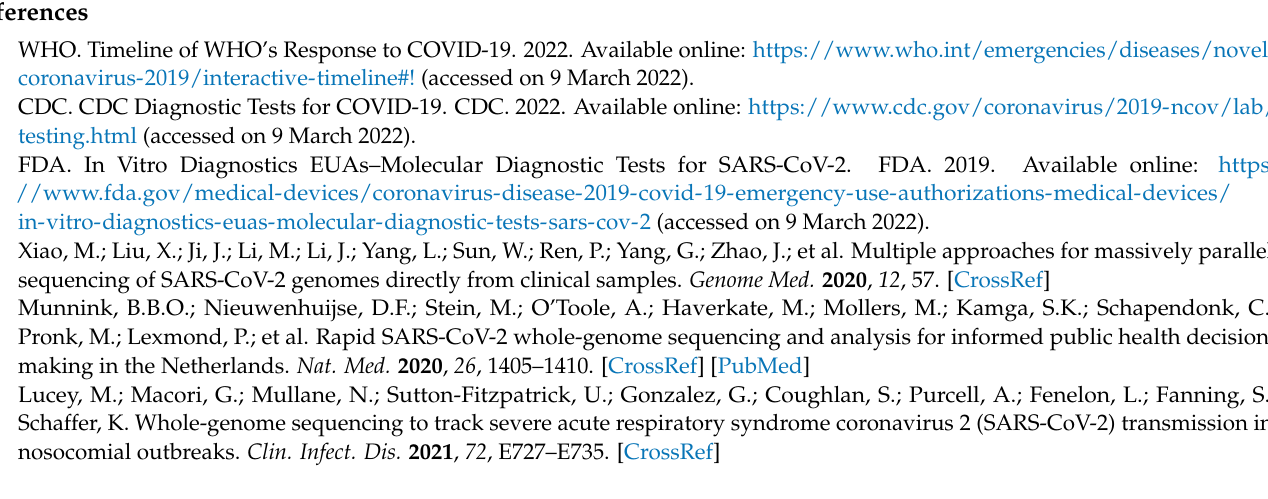
Table S1: Alignment quality within each sequencing run. Table S2: Correlation calculations. Table S3a: Amplicon success rates (sorted by mean percentage of amplicon’s reads within total reads, highest to lowest). Table S3b: Amplicon success rates (sorted by percent of samples with <50 reads, lowest to highest). Text S1: Sequences of South African samples chosen for B.1.1.529 amplicon failure prediction not available in the GISAID. Table S4: Sample, library, and sequencing metrics. Table S5: Sequencing quality metrics within different sample and library